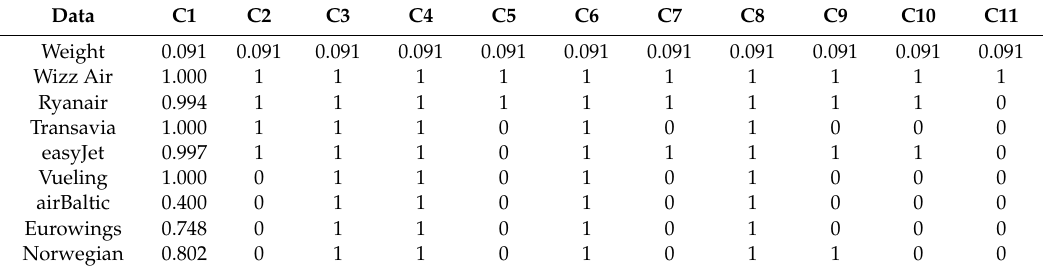
Table A1. Full calculations of the LCC criteria TOPSIS.